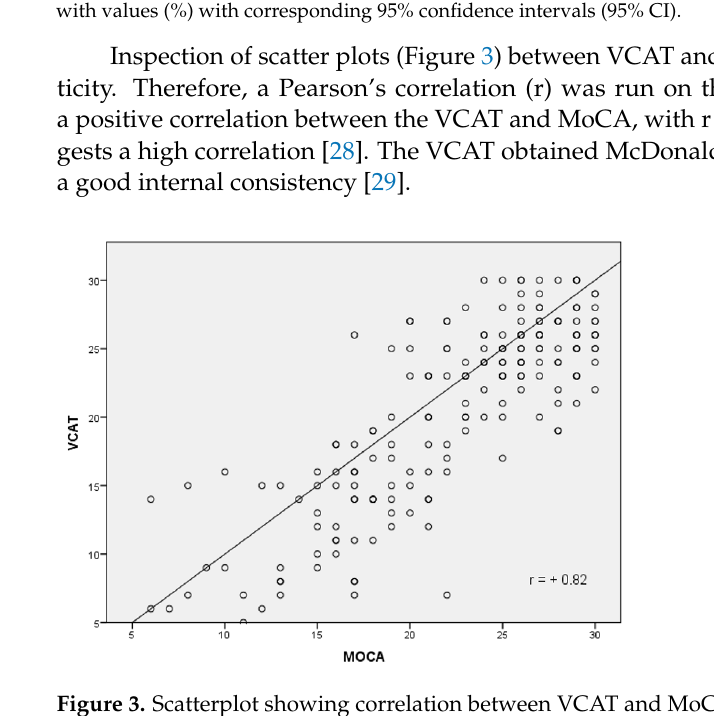
Figure 3. Scatterplot showing correlation between VCAT and MoCA score. VCAT, Visual Cognitive assessment Test; MoCA, Montreal Cognitive Assessment.